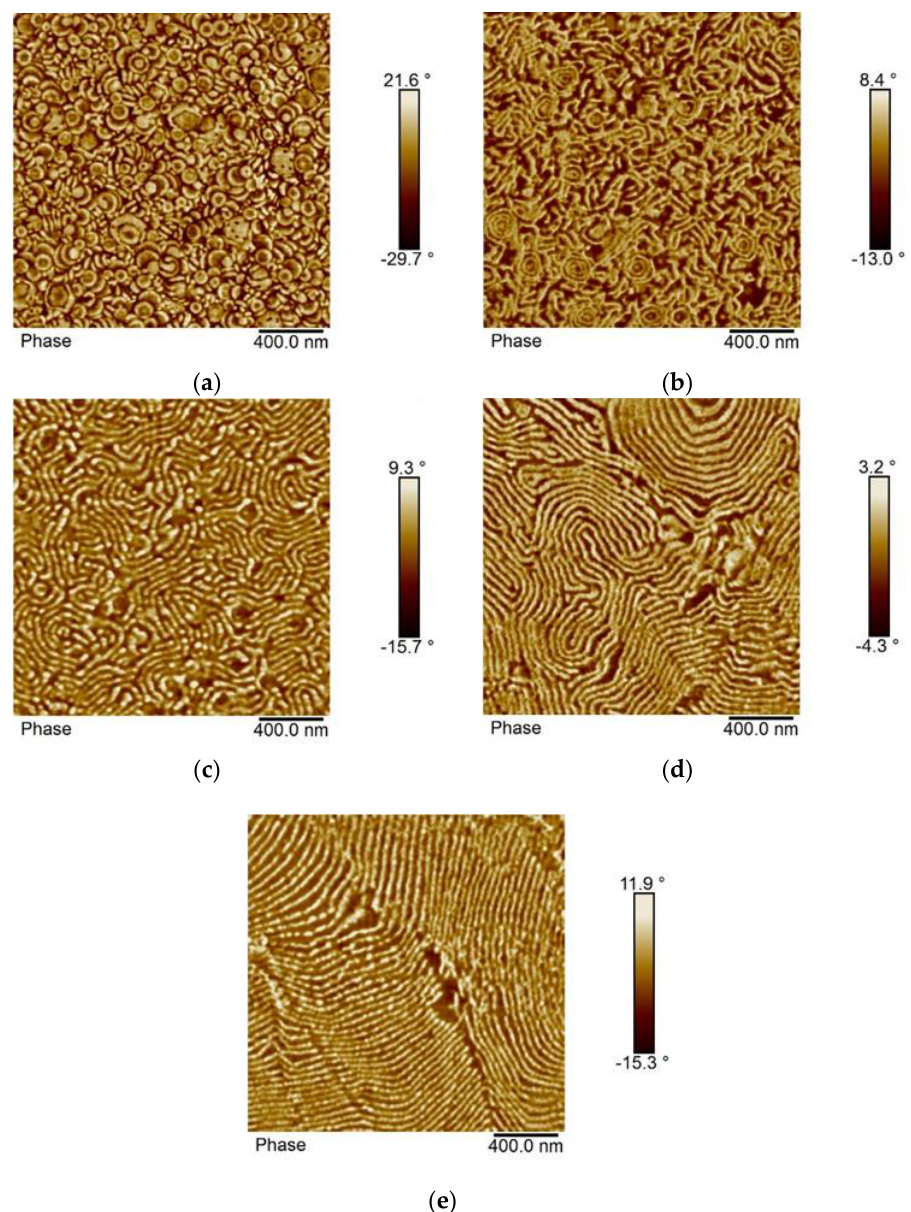
Figure 5. Atomic force microscopy (AFM) phase images of the sample p(St50/2EHA50). ( a ) Top surface of the latex film dried at room temperature; ( b ) cross-section of the latex film dried at room temperature; ( c ) cross-section of the latex film dried at room temperature and annealed at 100 °C for 30 min; ( d ) cross-section of the latex film dried at room temperature and annealed at 100 °C for 96 h; and ( e ) cross-section of a film cast from tetrahydrofuran (THF) solution.